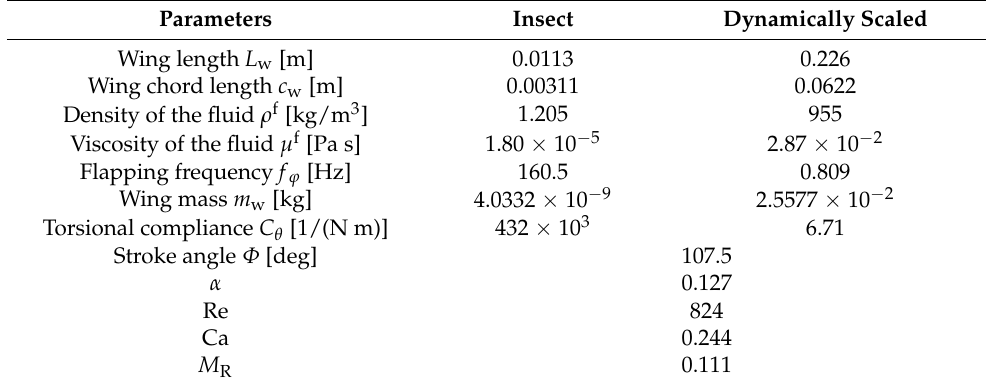
Table 1. Summary of the model parameters for the insect and dynamically scaled